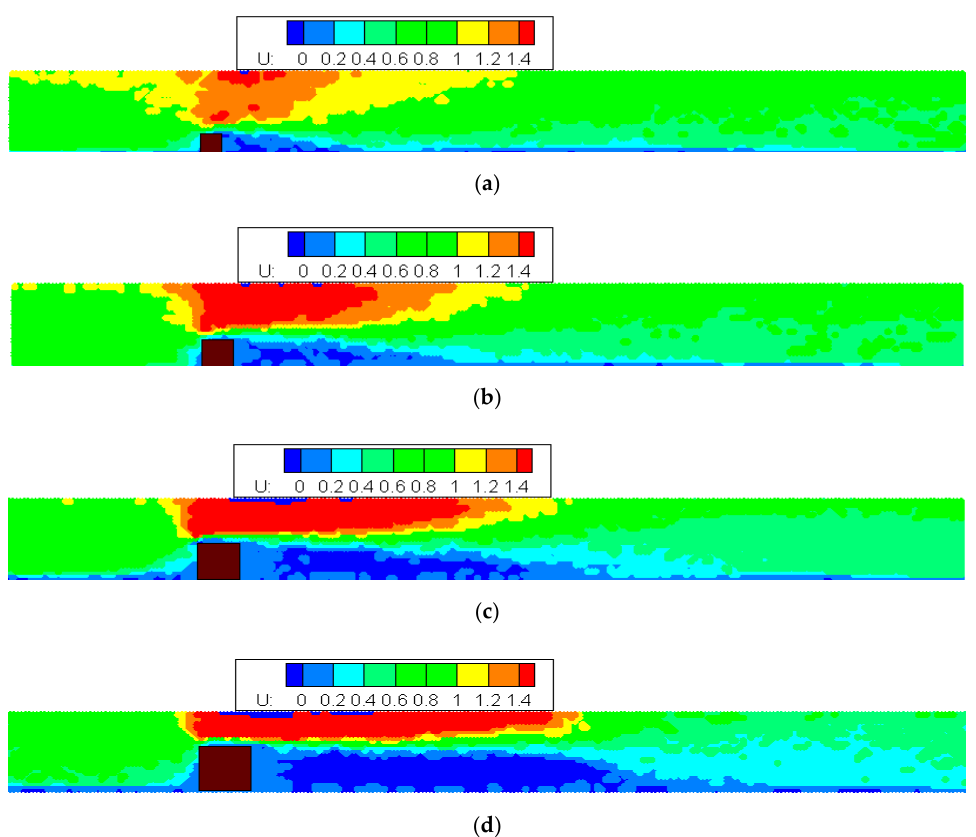
Figure 10. Flow field velocity distribution of di ff erent volumes of porous media at a porosity of 0.5. U: Longitudinal velocity ( m / s ). ( a ) Pore structure: 0.6 × 0.6 (m 2 ); ( b ) Pore structure: 0.9 × 0.9 (m 2 ); ( c ) Pore structure: 1.2 × 1.2 (m 2 ); ( d ) Pore structure: 1.5 × 1.5 (m 2